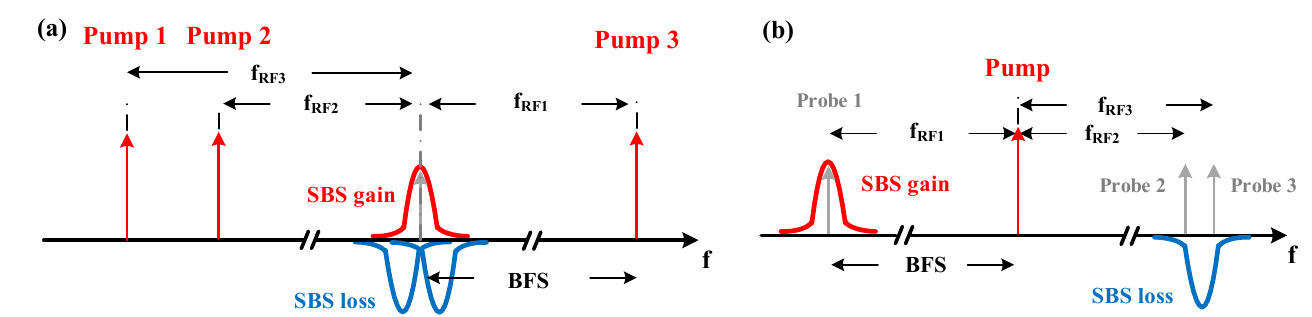
Figure 4. Schematic of ( a ) multi-pump wave and ( b ) multi-probe wave scheme. Red arrows mark the pump and gray arrows the probe